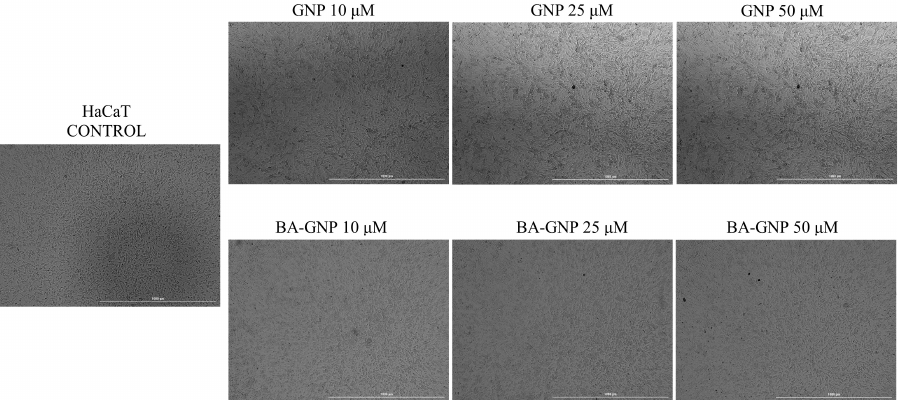
Figure 8. Representative images of the morphological aspect of HaCaT cells after treatment for 24 h with GNP (diluted to match the same gold content as for BA-loaded NPs at 10, 25 and 50 μΜ ) and BA-GNP (10, 25 and 50 μΜ ). The scale bar was 100 μ m.